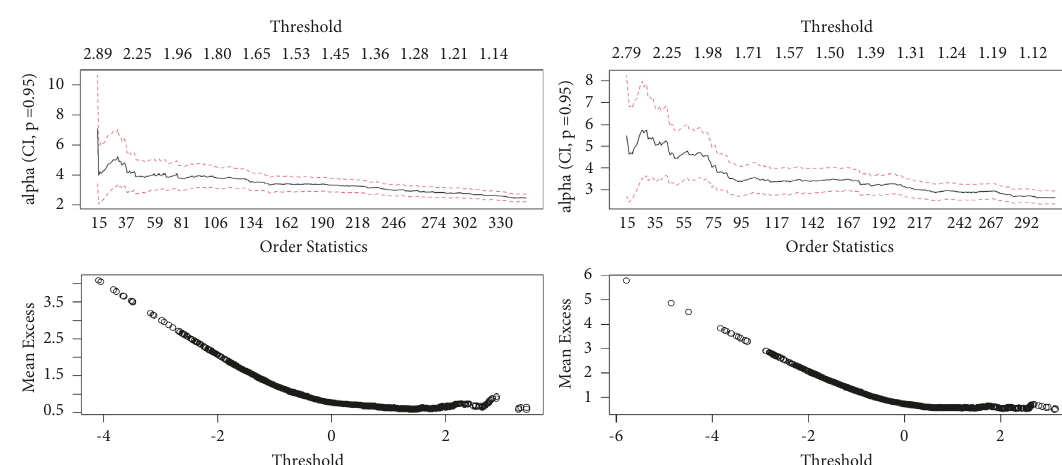
Figure 10: Soybean oil-Hill plots and the MEF plots. The top is the Hill plot, the bottom is the MEF plot, the left is the negative returns plots and the right is the positive returns